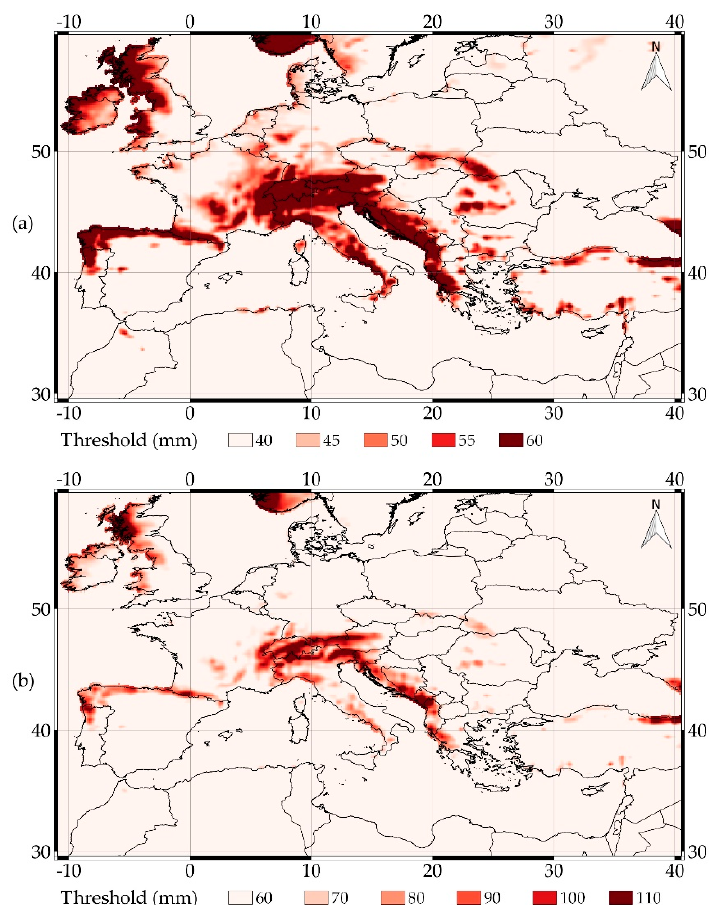
Figure 6. The maps show the rainfall thresholds that are currently applied to WRF data by ERDS for the extreme rainfall detection in the 24 ( a ) and 48 ( b ) hour durations. the extreme rainfall detection in the 24 ( a ) and 48 ( b ) hour